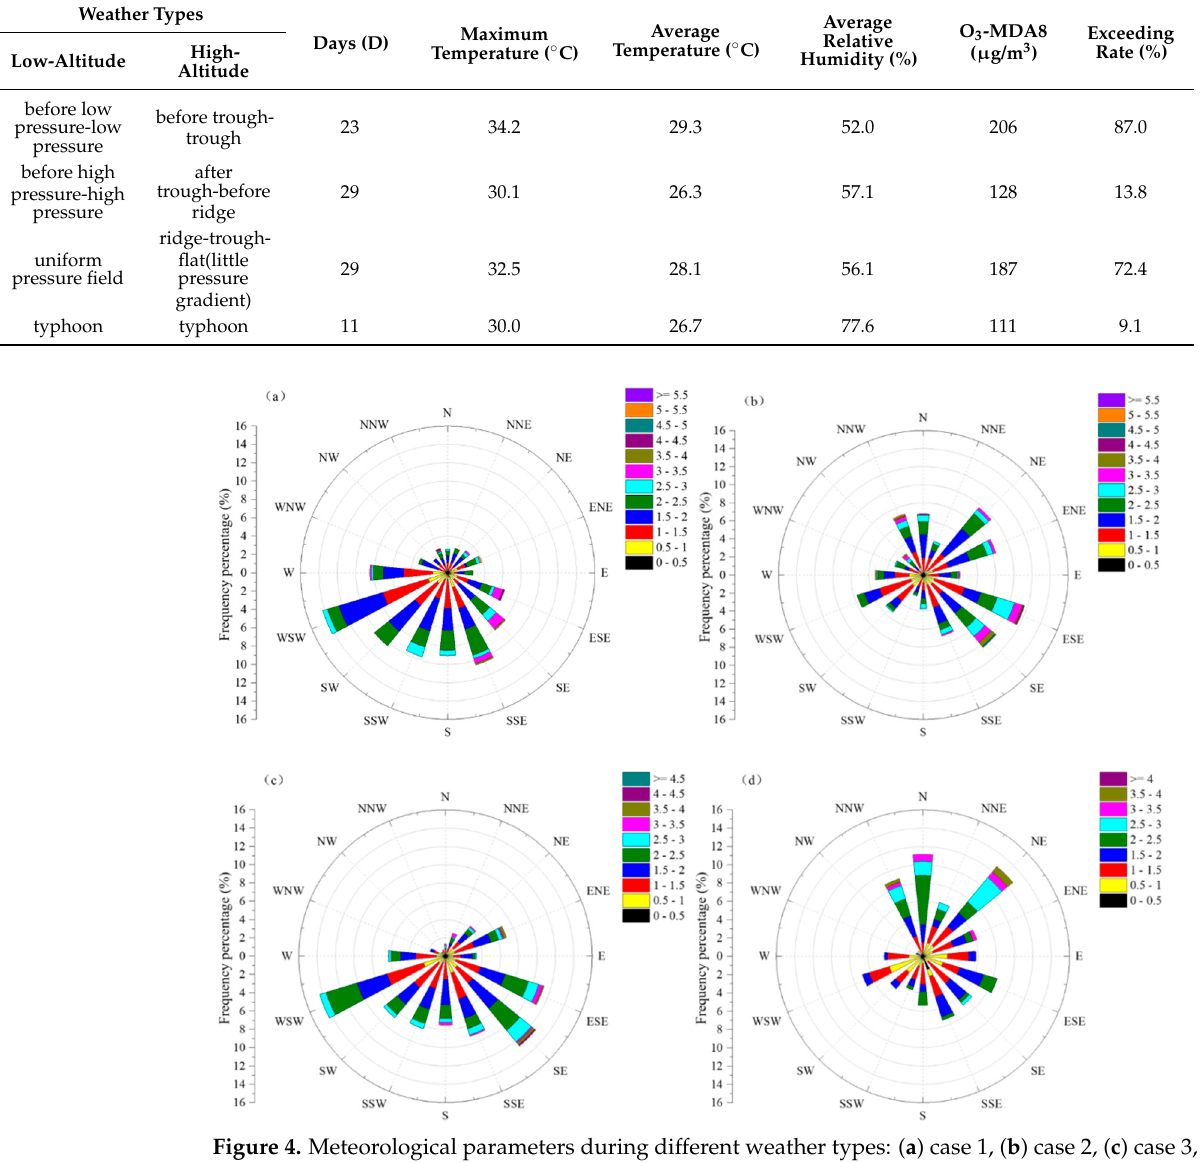
Table 1. Statistics of weather types in summer 2019.